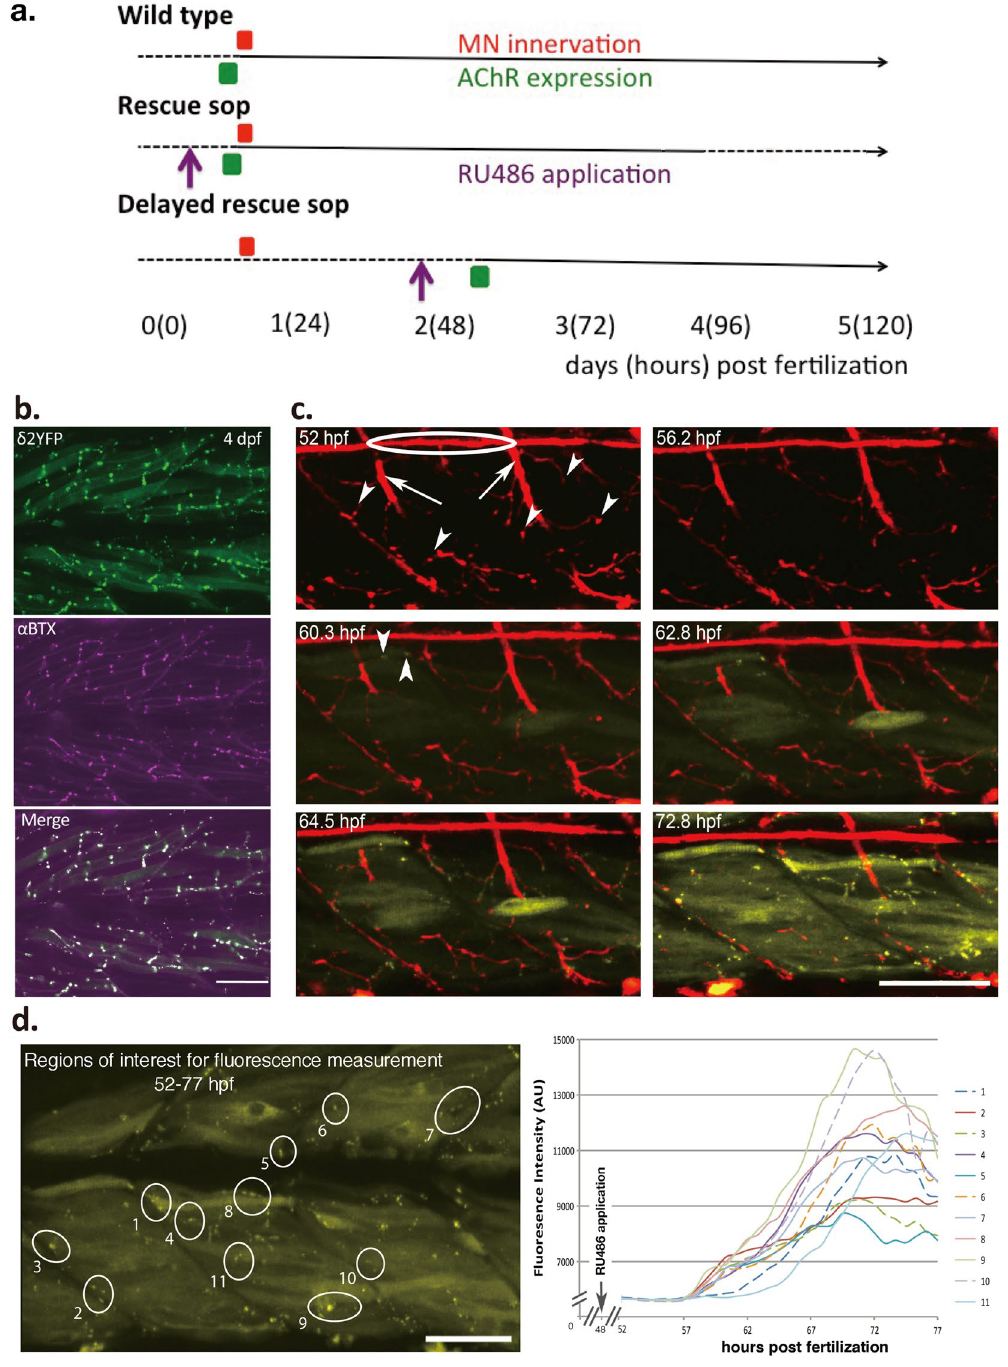
Figure 1. Synapse formation in delayed rescue sop . ( a ) A summary of the experimental paradigm, showing events related to the synapse development and manipulations along the developmental time course. Numbers indicate days post fertilization (hours post fertilization in parentheses). Dashed lines indicate periods when zebrafish embryos are immotile, and solid lines indicate stages when embryos exhibit mobility. Timing of motor neuron axon innervation (red), AChR expression (green) and RU486 application (purple) are indicated by boxes and arrows. ( b ) δ 2YFP (top), α BTX (middle) and merged (bottom) in the trunk region of a 4 dpf delayed rescue sop are shown. ( c ) Time-lapse images of axons (red) and AChRs (yellow) in vivo from delayed rescue sop embryos. In the 52 hpf panel, lateral line axons (circled) and motor neuron trunks (arrows) are visualized. Motor neuron terminals are indicated by arrowheads. In the 60.3 hpf panel, the first expressed AChR clusters are detected, indicated by arrowheads. ( d ) Analysis of fluorescence intensity of identified regions with AChR clusters in delayed rescue sop . Fluorescence from the marked regions of interest (labeled 1–10) was measured and plotted against hours post fertilization. RU486 was applied at 48 hpf, before the measurement of fluorescence started. Scale bars: 50 µ